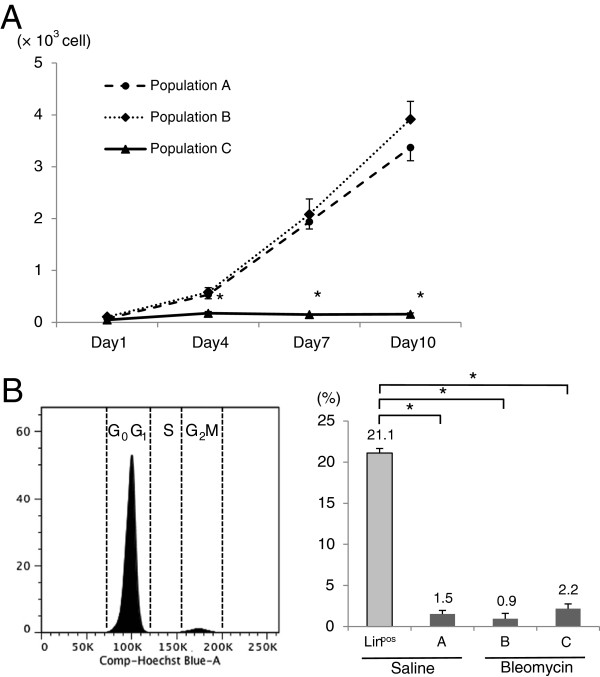
In-vitro and in-vivo proliferative capacity of myofibroblasts and fibroblasts.(A) Two hundred sorted cells from populations A, B, and C were grown in 12-well plates. The graph represents the number of adherent cells of each population, which were counted on days 1, 4, 7, and 10 after sorting. Experiments were performed in triplicate. Results represent the mean (± s.d.) of three experiments. *, P < 0.01. (B) The left figure shows the cell-cycle distribution of the DNA histogram from Hoechst 33342-stained cells of population A. The high peak on the left side represents cells in the G0G1 phase, and the low peak on the right side represents cells in the G2M phase. The region between the two peaks represents cells in the S phase. The proportion of cells in the G2M phase was compared among lineage-specific cell surface marker-positive cells of saline-treated lungs (lineage-positive cells of saline-treated lungs), and populations A, B, and C (right). The bar graph represents the proportion of cells in the G2M phase. Experiments were performed in triplicate. Results represent the mean (± s.d.) of three experiments. Asterisks indicate P < 0.001. s.d., standard deviation.